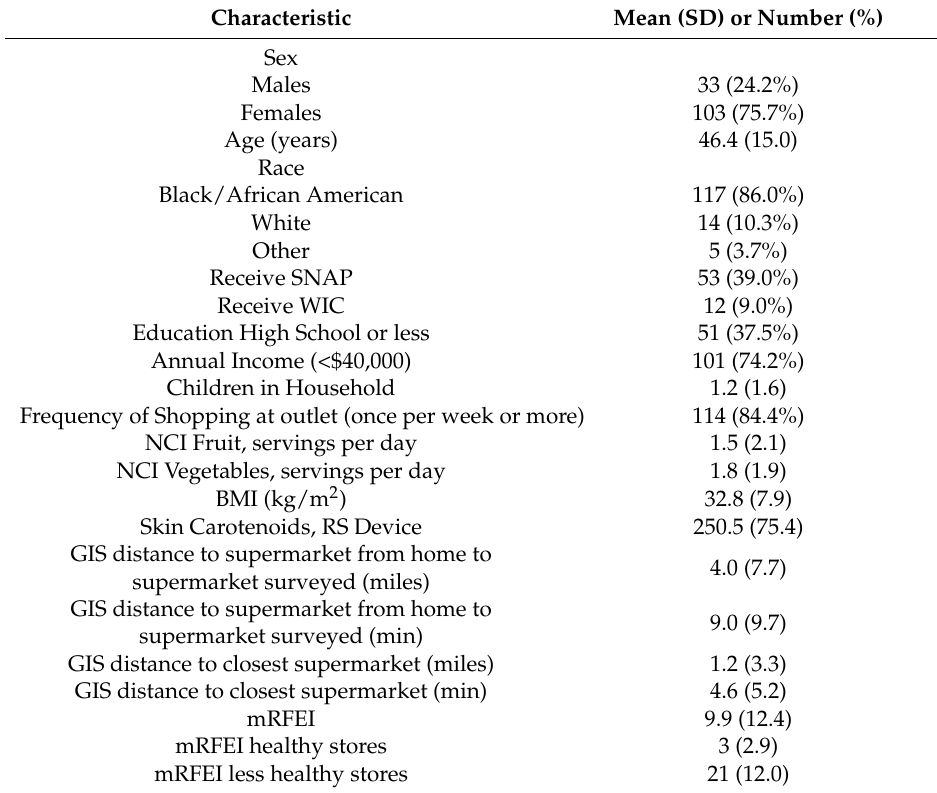
Table 1. Participant sociodemographic and health-related characteristics ( n =